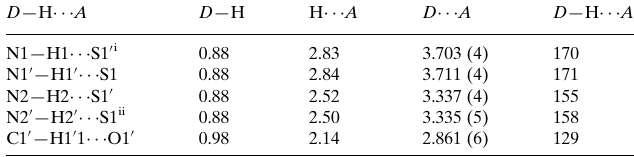
Hydrogen-bond geometry (A˚ , (cid:3)